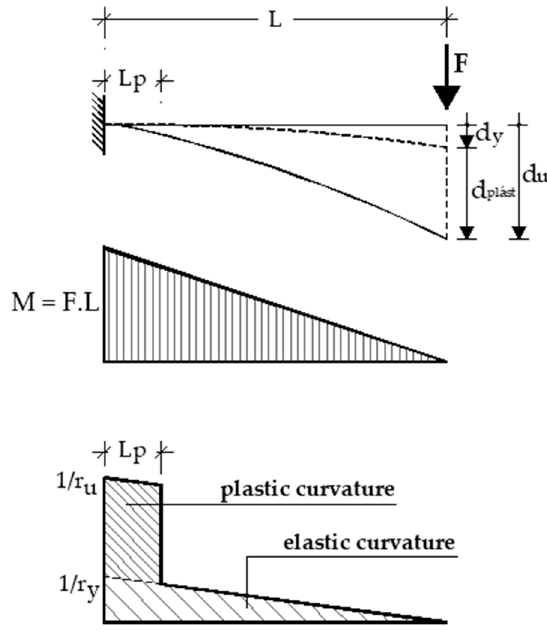
Figure 18. Ultimate, yield and plastic